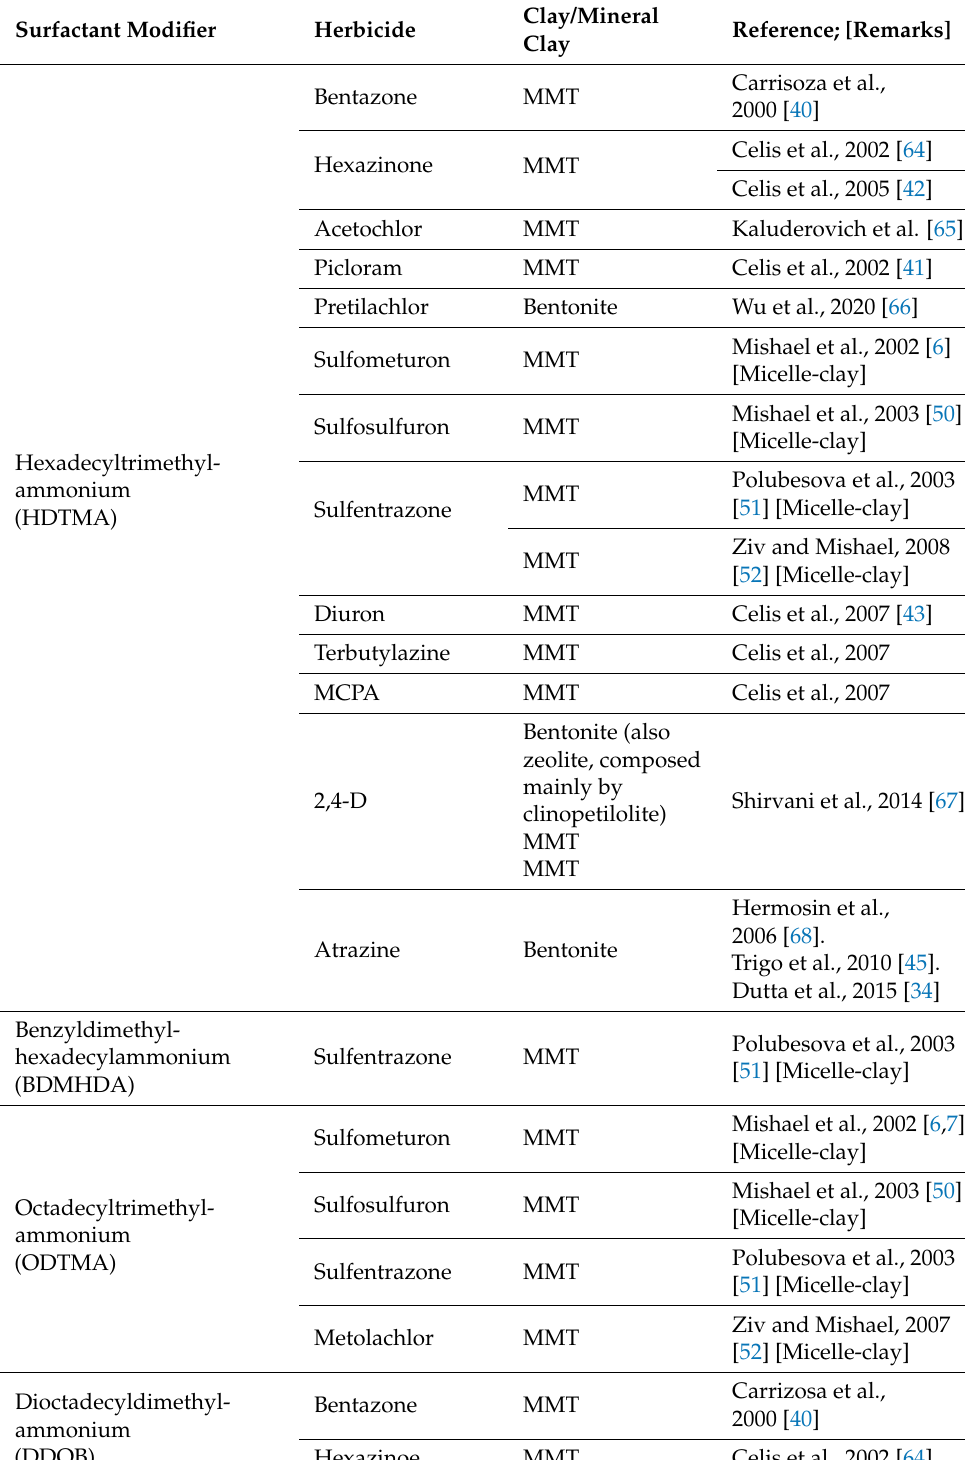
Table 4. Slow release formulations (SRFs) of several representative herbicides, based on